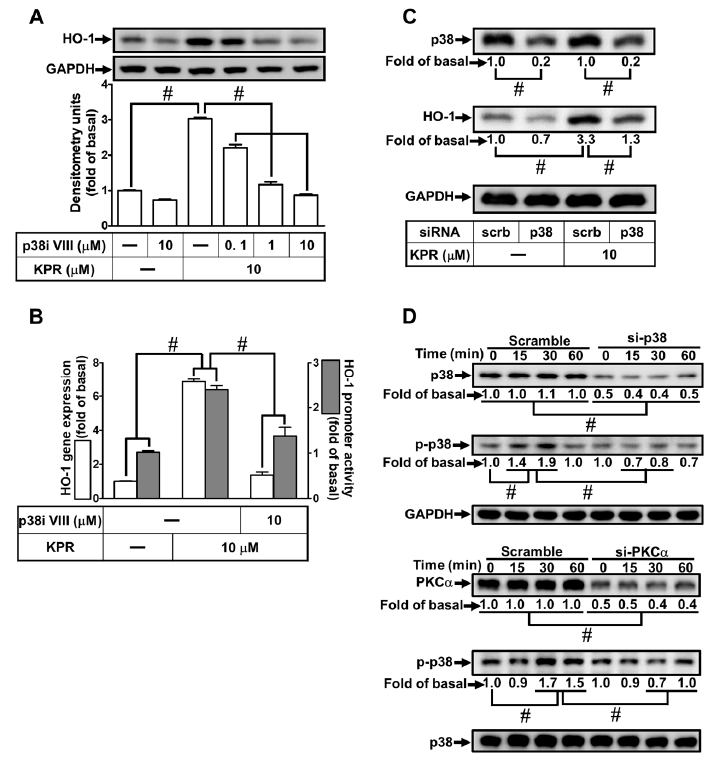
Figure 8. KPR-induced HO-1 expression is mediated through p38 MAKP. ( A ) HPAEpiCs were pre- treated with various concentrations of p38i VIII for 1 h and then incubated with DMSO or KPR (10 µ M) for 16 h. The protein expression of HO-1 was determined by Western blot using GAPDH as a loading control. ( B ) Cells were pretreated with or without p38i VIII (10 µ M) for 1 h, and then incubated with DMSO or KPR (10 µ M) for the indicated time intervals. The HO-1 mRNA expression and promoter activity were analyzed by real-time PCR (6 h) and promoter activity assay (8 h), respectively. ( C ) Cells were transfected with scrambled (scrb) or p38 siRNA, and then incubated with KPR (10 µ M) for 16 h. The protein levels of HO-1, p38, and GAPDH were determined by Western blot. ( D ) Cells were transfected with p38 or PKC α siRNA, and then incubated with KPR (10 µ M) for the indicated time intervals. The levels of phospho-p38, total p38, and total PKC α were determined by Western blot. Data are expressed as mean ± SEM ( n = 5), analyzed with one way ANOVA and Dunnett’s post hoc test. # p < 0.01, as compared with the cells exposed to vehicle alone; or significantly different as